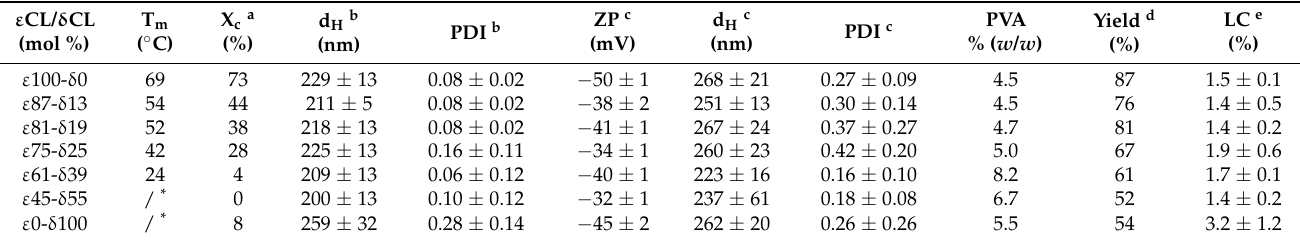
Table 1. Overview of PCL[BRP-187] NP properties prepared in THF using a polymer concentration of 2.5 mg mL − 1 . ε CL/ δ CL (mol %)